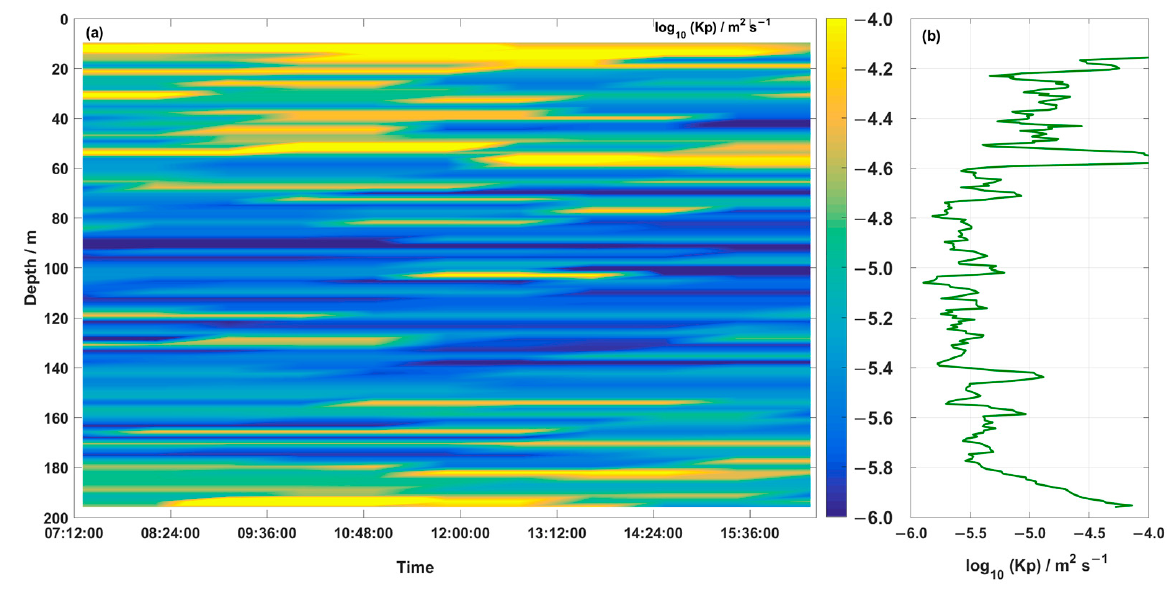
Figure 10. Depth–time maps of ( a ) diapycnal diffusivity and ( b ) the temporally averaged diapycnal diffusivity. The dissipation rate ( ε ) in this section varied from 1.41 × 10 − 10 to 4.18 × 10 − 7 W · kg − 1 . The larger turbulent energy dissipation occurred in the surface mixing layer, which was larger than that of the thermocline and bottom mixing layer by about three orders of magni- tude. Due to the effects of sea surface wind energy and buoyancy flux, the vertical mixing of the surface mixing layer was large and uniform. In the upper boundary of the thermocline, there was a violent mixing process, and the change of turbulent energy dissipation rate and mixing rate was very obvious. With the increase in depth, the mixing below the thermocline gradually weakened, in the order of 10 − 10 ∼ 10 − 9.5 W · kg − 1 . Therefore, the thermocline was like a “barrier.” Above the “barrier” was an active open area, where wind energy and thermal radiation provided energy for strong turbulence mixing, whereas below the “bar- rier” turbulence mixing became very weak. The strong and stable thermocline in the water hindered the transfer of wind and heat energy from the surface mixed layer to the deep layer. The variation range of diapycnal diffusivity was 10 − 6 ~10 − 4 m 2 · s − 1 , and was higher between the surface mixing layer and the upper boundary of thermocline. These results are consistent with those of Shang et al. (2017) [27], who also found that the turbulent dissipation rate and diapycnal diffusivity would decrease under the thermocline